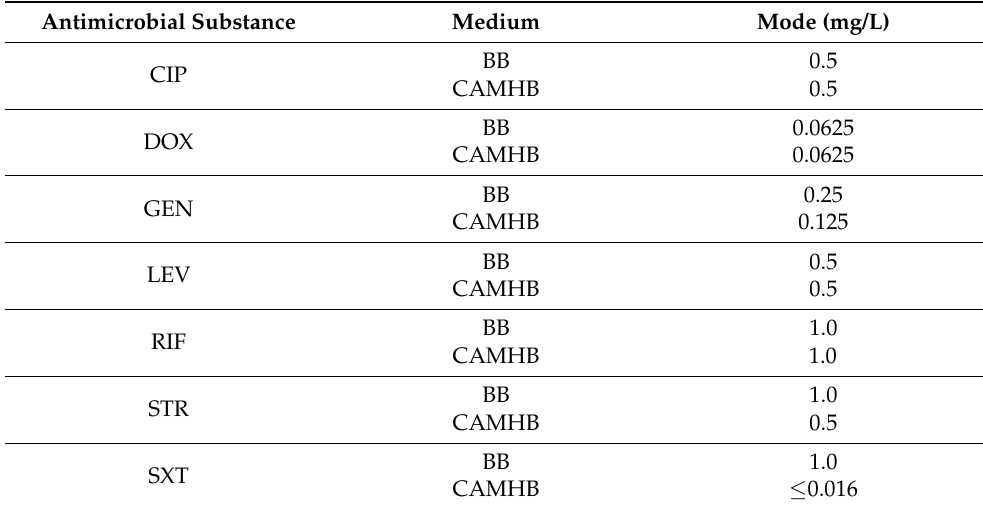
Table 1. Calculated mode MICs from the BMD results of 57 clinical B. melitensis WT-isolates with CAMHB and BB culture medium in